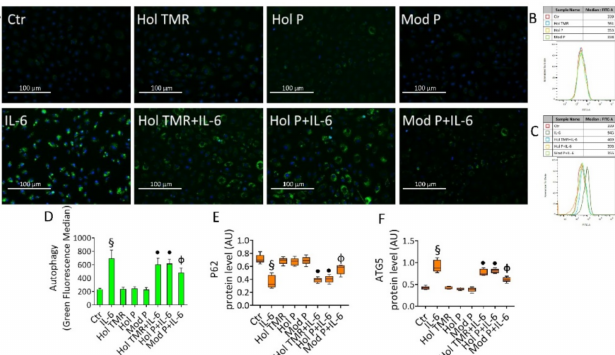
Figure 5. Milk extract effects on autophagy. ( A ) Representative images by fluorescence microscopy and ( B – D ) flow cytometry analysis, expressed as fluorescence median ± SD of n = 3 experiments, of green detection reagent in ECs treated with Hol TMR, Hol P, and Mod P milk (20% v / v ) for 72 h, IL-6 (20 ng/mL) for 24 h, or pretreated for 16 h with milk before starting stimulation for 24 h with IL-6. Scale bars = 100 µ m. Control cells (Ctr) were treated with the corresponding highest volume of HBSS-10 mM Hepes. Western blotting analysis of ( E ) p62 and ( F ) ATG5 expression levels represented as boxplots of densitometric mean values, expressed as arbitrary units (AU) of n = 5 different experiments: § p < 0.001 vs. Ctr; • p < 0.05 vs. IL-6; Φ p < 0.01 vs.